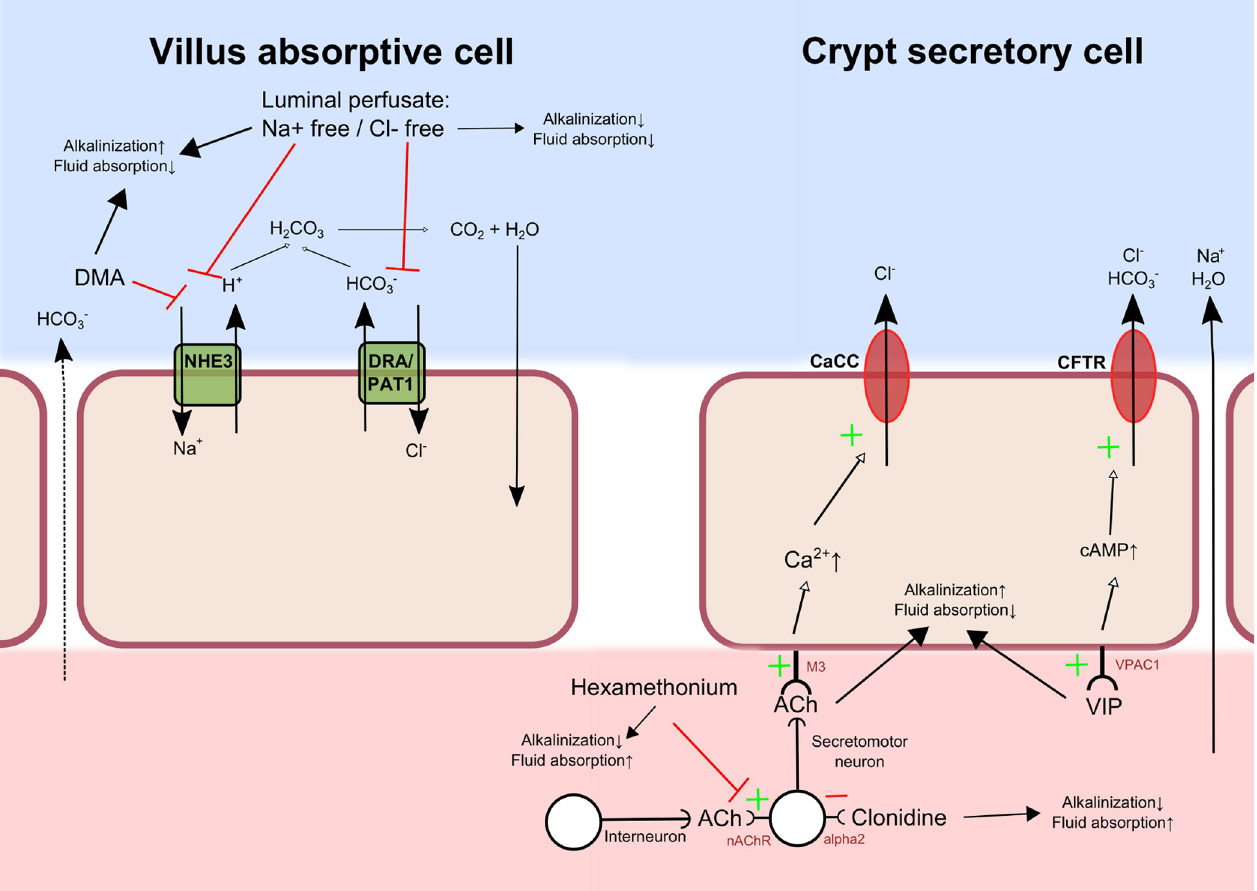
Fig 11. A summary of the effects on duodenal fluid absorption and luminal alkalinisation in the villi and crypts. Effects on rat duodenal fluid absorption and luminal alkalinisation of clonidine combined with sodium and/or chloride free luminal perfusates, luminal inhibition of the Na + /H + exchanger (NHE3) with DMA, and intravenous administrations of the vasoactive intestinal peptide (VIP) or hexamethonium, a non-selective nicotinic receptor antagonist. DRA/ PAT1—chloride anion exchanger, CaCC–calcium-activated chloride channels, CFTR—Cystic fibrosis transmembrane conductance regulator, Ach– acetylcholine, cAMP–Cyclic adenosine monophosphate, nAChR—Nicotinic acetylcholine receptor, alpha2—Alpha-2 adrenoceptor, VPAC1—Vasoactive intestinal polypeptide receptor 1, M3—Muscarinic M3 receptor.